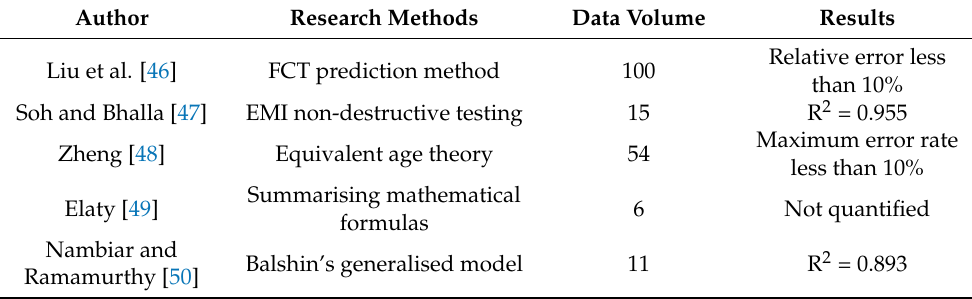
Table 3. Traditional concrete-strength prediction